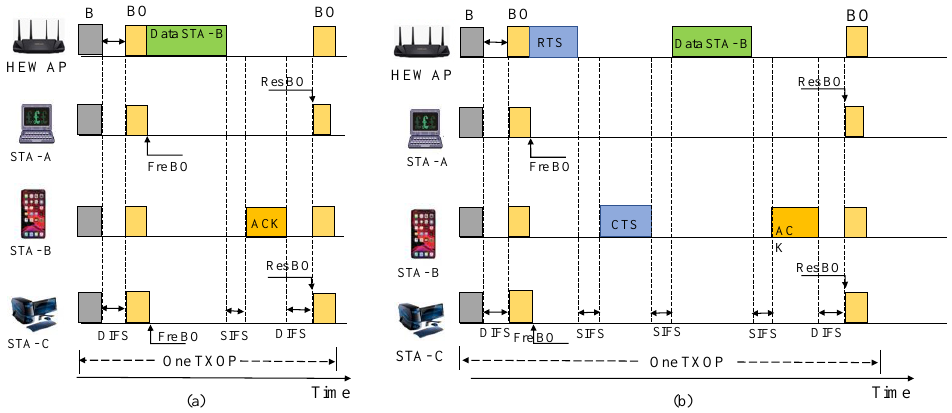
Figure 1. DCF channel-access-mechanism for the IEEE 802.11 ( a ) DCF Basic and ( b ) DCF RTS/CTS transmission